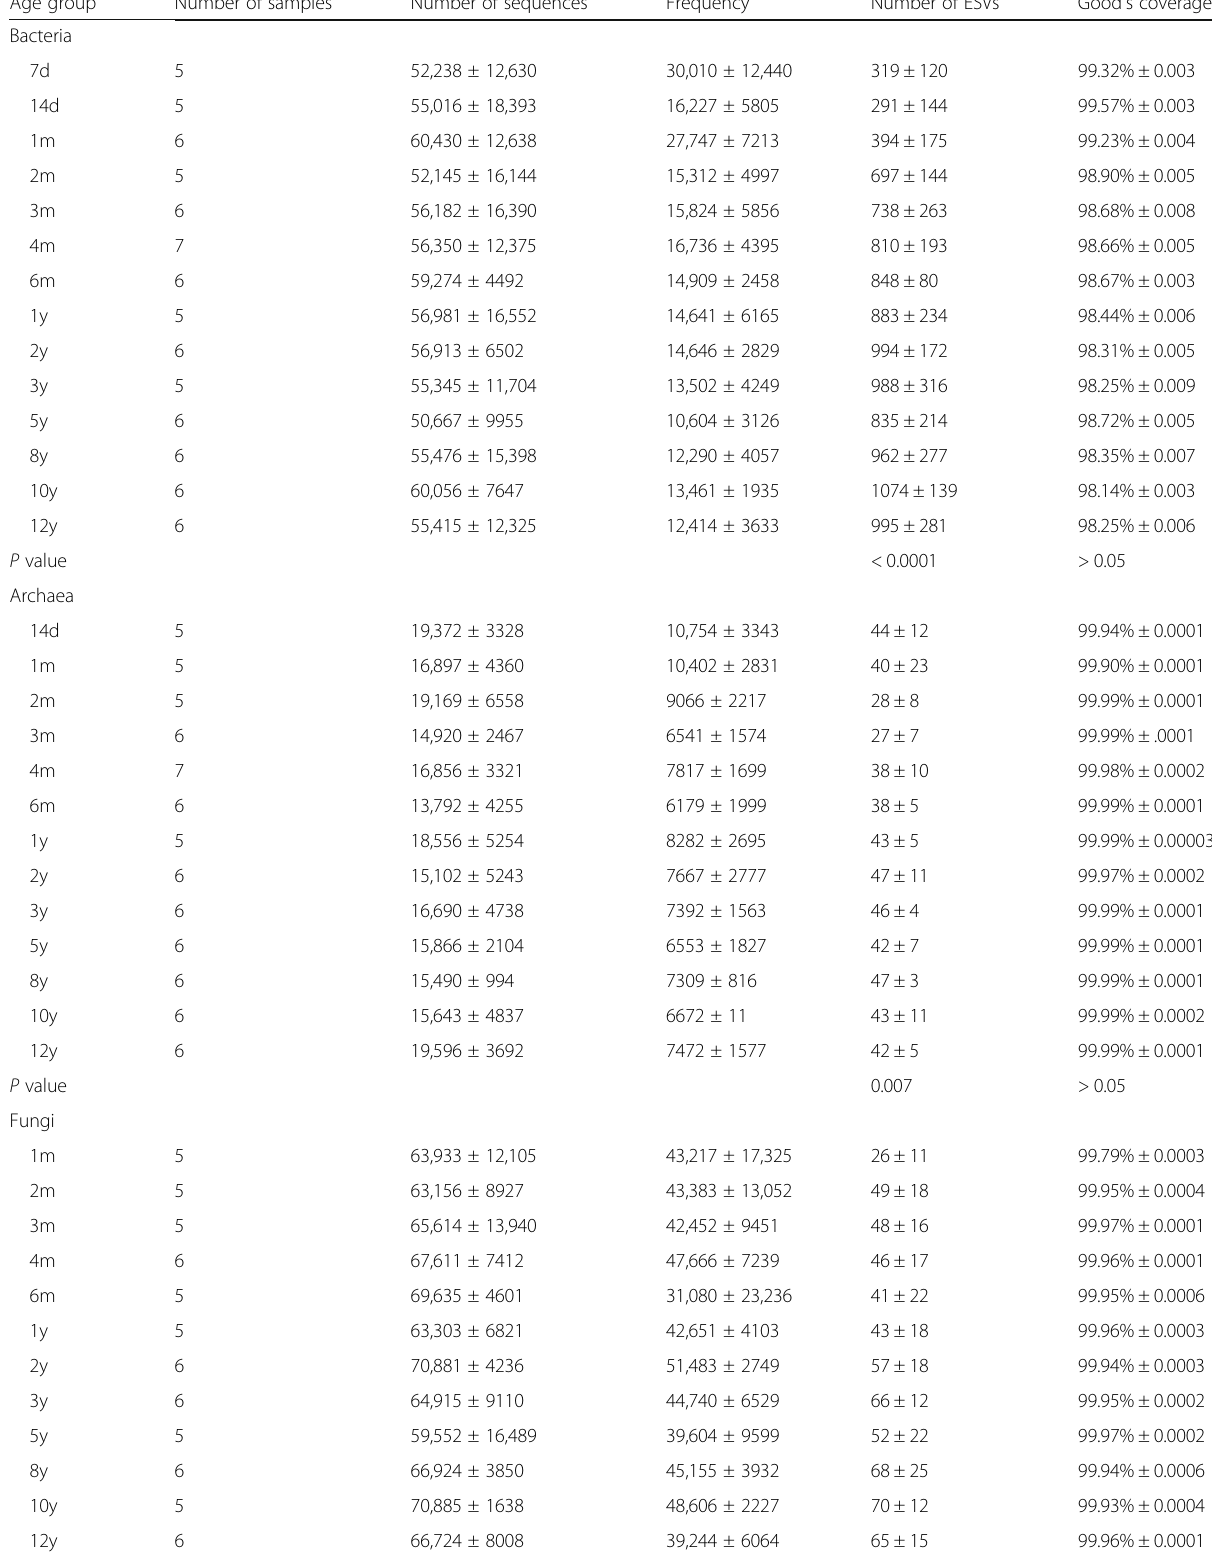
Table 1 Sample information and sequencing statistics obtained using the DADA2 algorithm in QIIME2 Age